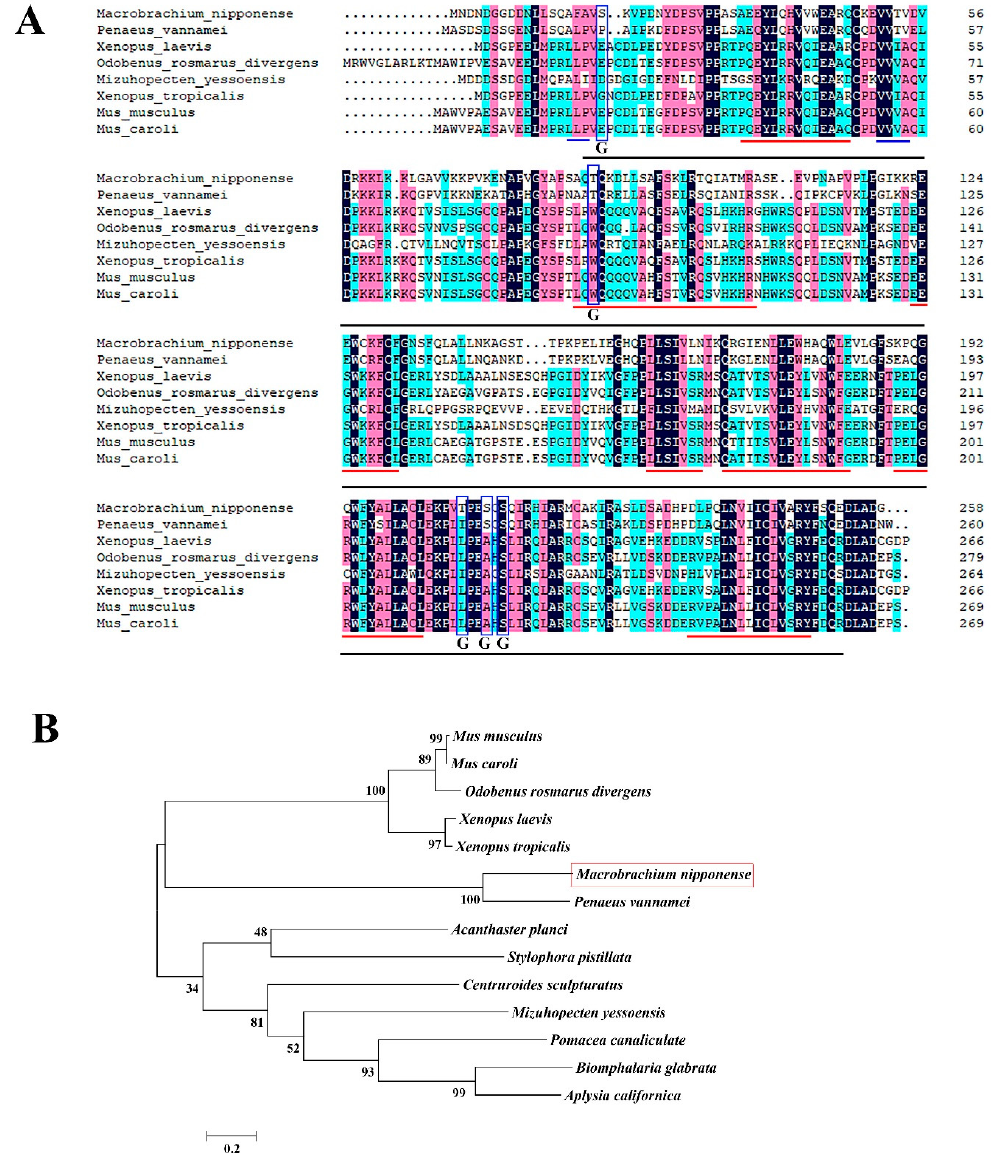
Figure 2. ( A ) The alignment of amino acid sequences of Gem-associated protein 2-like isoform X1 ( GEM ). Black line indicated SIP1 superfamily; Red lines indicated membrane helix; Blue lines indicated membrane strand; Black rectangles indicated the five potential O-GlcNAc sites. ( B ) The phylogenetic tree of GEM from di ff erent organisms based on amino acid sequence comparisons. Species names and types of GEM are listed on the right of the tree. Red rectangles indicated M. nipponense